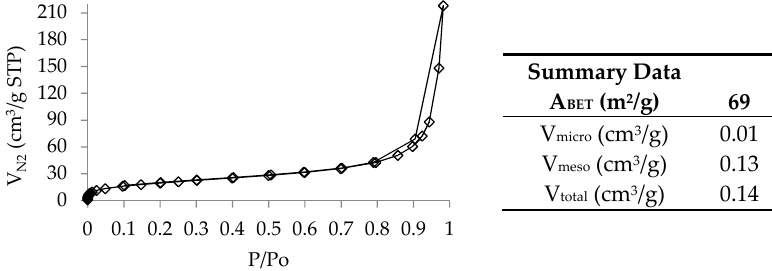
Figure 3. The XRD pattern of ST char.